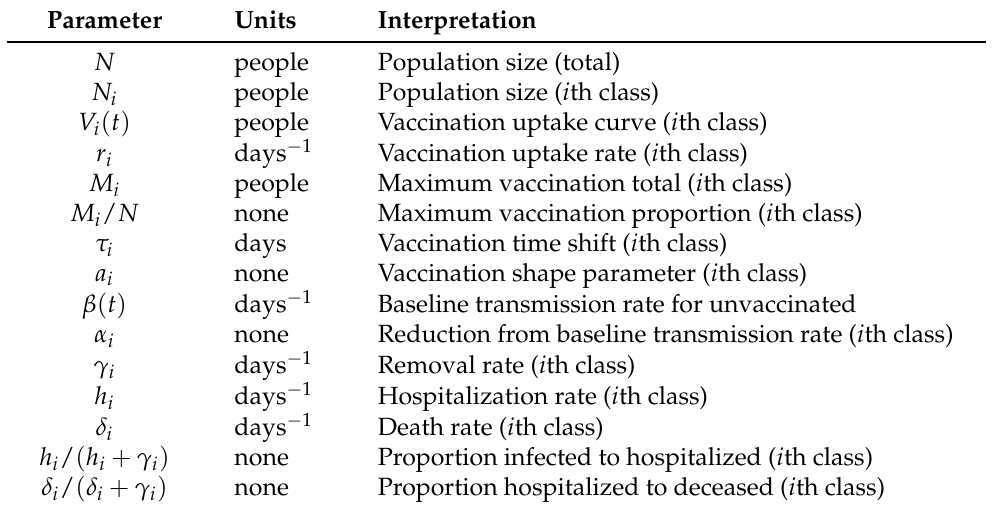
Table 1. Parameters and rate functions for the n -stage vaccination model (1) and corresponding system of ordinary differential Equation (2) with the i th vaccination dose uptake curve V i ( t ) (4). Parameter Units